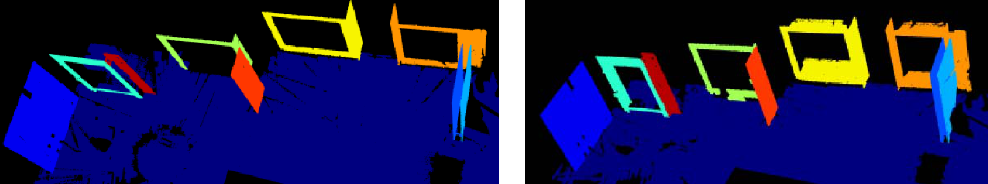
Figure 10. Segmentation results of different NN values.